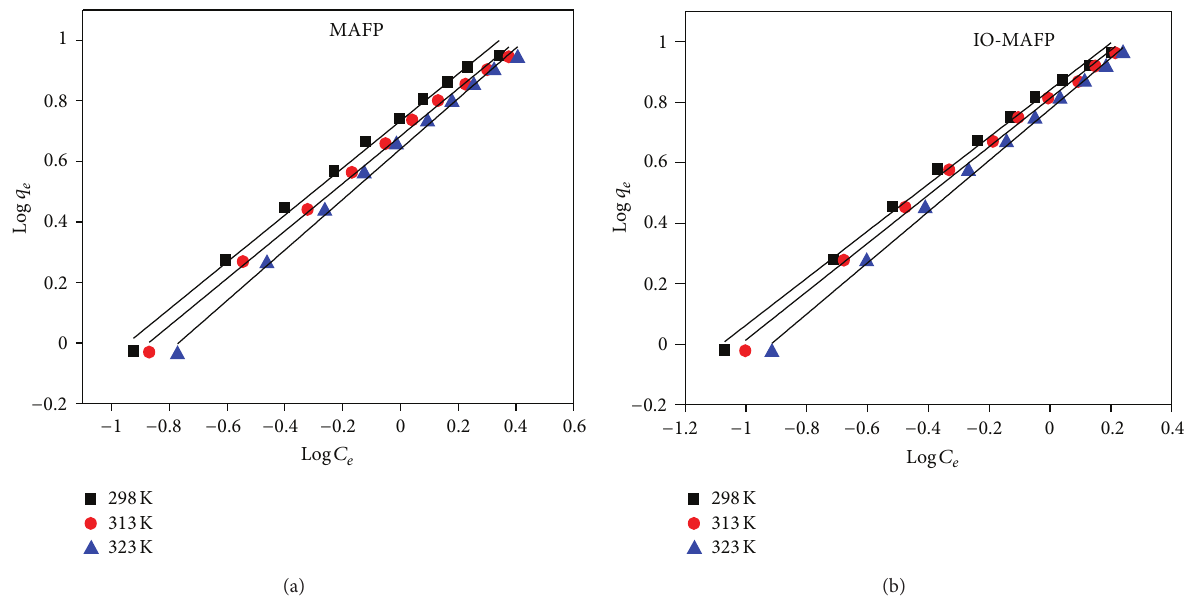
Figure 12: Freundlich isotherm of Co(II) sorption oto MAFP and IO-MAFP biomasses.